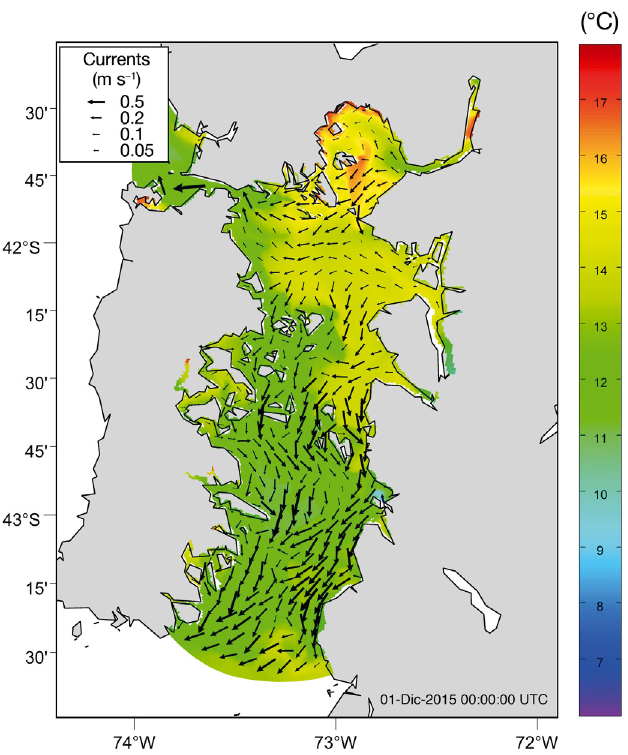
Fig. 2. Surface water temperature and surface current vector field for Los Lagos region, southern Chile, at midnight on 1 December 2015, generated by the hydrodynamic SHOC model (Herzfeld